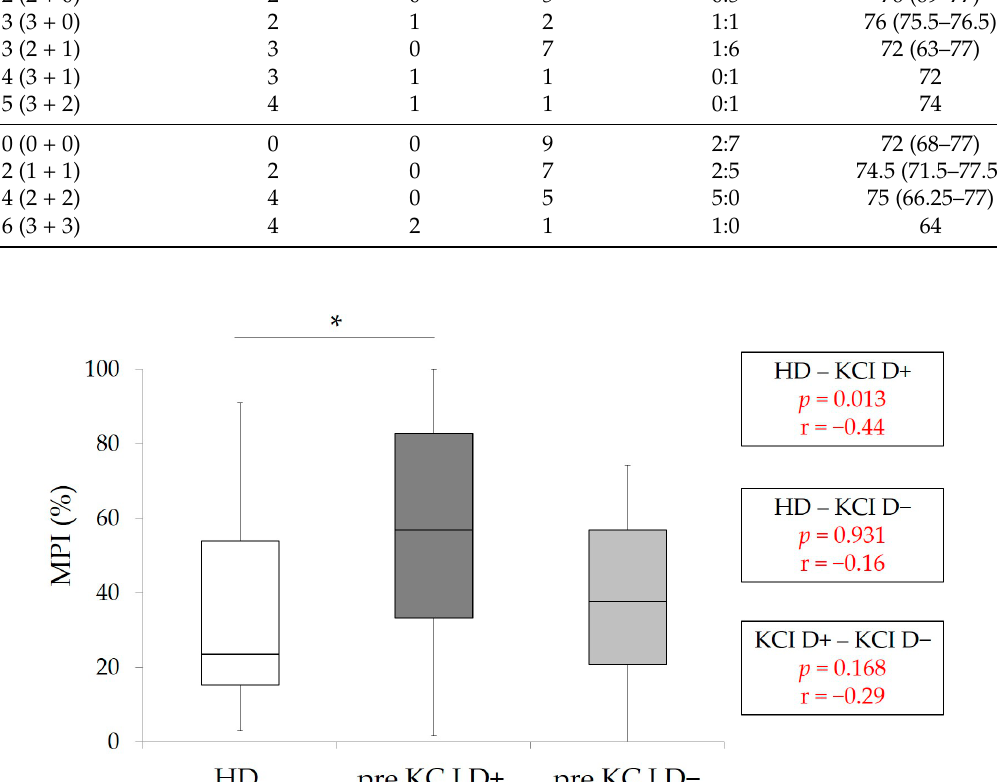
Figure 1. MPI in HD (control group), pre-MPI in KC I D+ and D − . * p < 0.05, Kruskal–Wallis with multiple comparison, r: effect size.